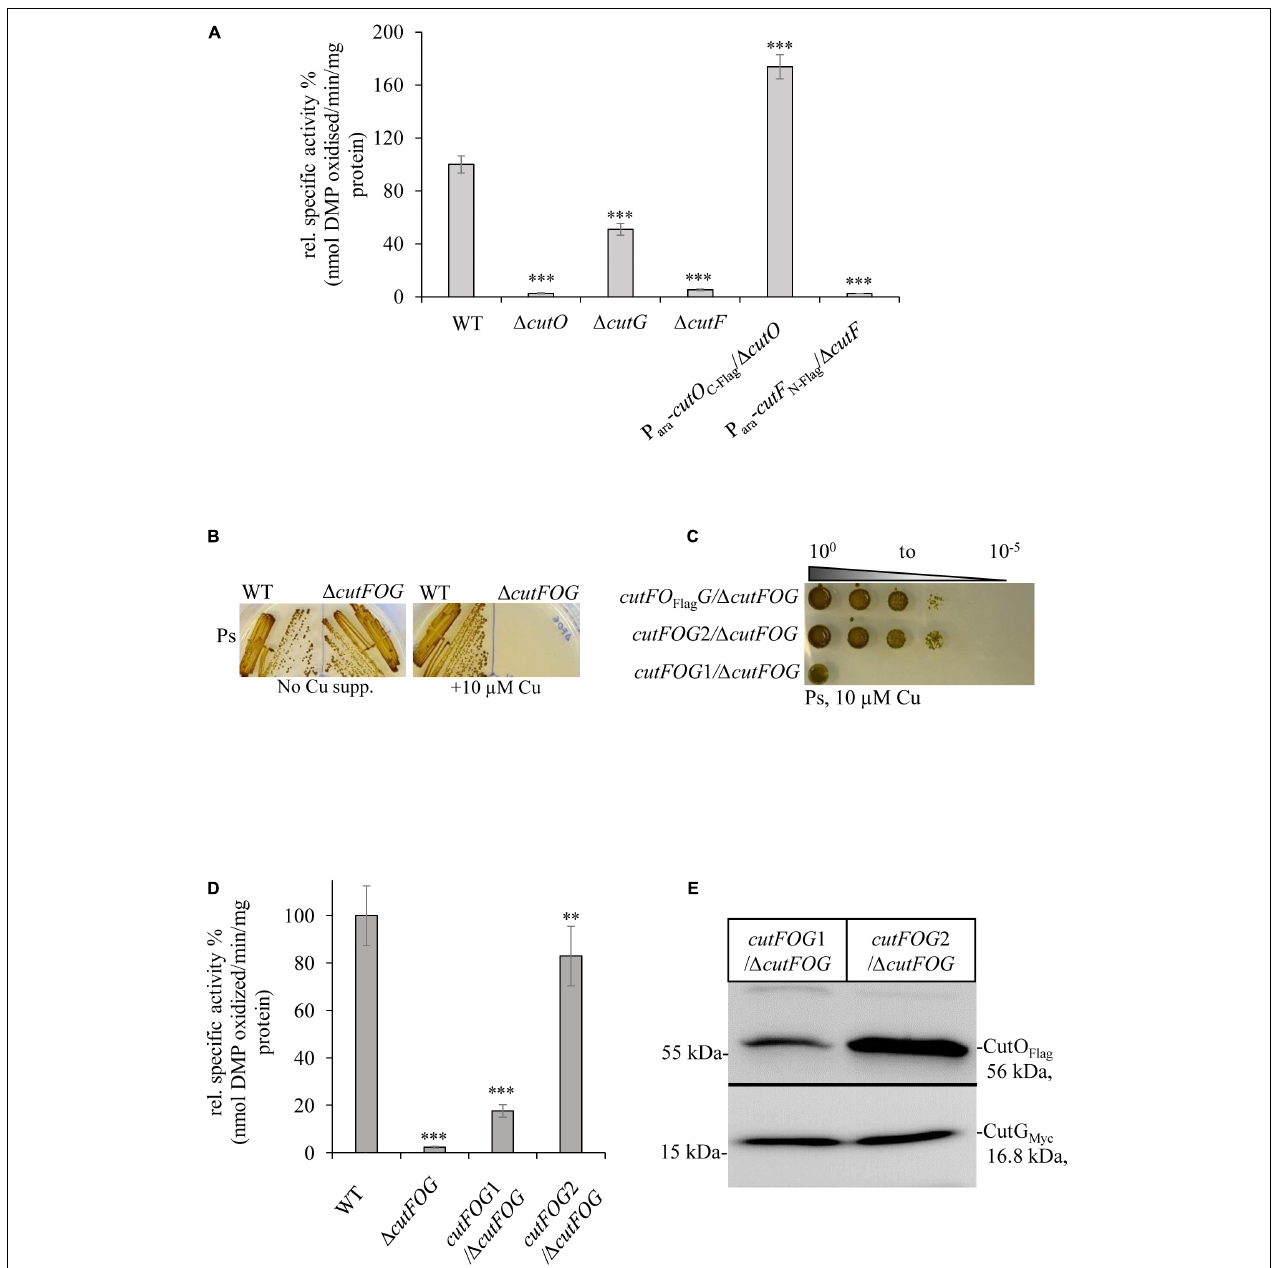
FIGURE 3 | CutF but not CutG is essential for CutO activity. (A) CutO activity of WT and the (cid:49) cutO, (cid:49) cutF, and (cid:49) cutG single mutant strains of R. capsulatus . The CutO activity was determined as described in the legend to Figure 1B . Epitope-tagged versions of cutO and cutF were expressed from an arabinose-inducible promoter from plasmid pRK415. The activity of WT was set to 100% and the relative activities of the indicated strains were calculated. Three independent experiments were performed with three technical replicates and the error bars reflect the standard deviation ( n = 9). Statistical analyses were performed as described in Figure 1 . ( ∗ ) refers to p - values ≤ 0.05; ( ∗∗ ) to p -values ≤ 0.01, and ( ∗∗∗ ) to p -values ≤ 0.001. (B) Cu sensitivity of the WT and the (cid:49) cutFOG triple knock-out strain, grown under PS conditions and in the presence or absence of 10 µ M CuSO 4 . (C) Spot assay for Cu sensitivity of the (cid:49) cutFOG strain expressing differently tagged plasmid-borne copies of the cutFOG- operon. In cutFO Flag G , CutO was C-terminally Flag-tagged. In cutFOG1 ( cutF C − Strep O Flag G MycHis ) and cutFOG2 ( cutF N − strep O Flag G MycHis ), all three genes were tagged, but contained the Strep-tag either at the C-terminus ( cutFOG1 ) or at the N-terminus ( cutFOG2 ) of cutF . (D) CutO activities of the strains shown in panel (C) . Periplasmic fractions were isolated from the indicated strains, grown in MPYE medium supplemented with 10 µ M CuSO 4 . 50 µ g protein of the periplasmic fractions were used in the assay. Three independent experiments were performed with three technical repetitions and the error bars reflect the standard deviation ( n = 9). The activity of WT was set to 100% and the relative activities of the other strains were calculated. Statistical analyses were as in Figure 1 . ( ∗ ) refers to p -values ≤ 0.05; ( ∗∗ ) to p -values ≤ 0.01, and ( ∗∗∗ ) to p -values ≤ 0.001. (E) Immunoblot analyses of the (cid:49) cutFOG strain harboring either the cutFOG1 or cutFOG2 constructs. 50 µ g of soluble protein and α -Flag antibodies were used for the detection of CutO (upper panel) and 75 µ g protein and α -Myc antibodies were used for detection of CutG (lower panel). Although Strep-tagged, CutF could not be detected in immunoblots in either construct, although the cutFOG2 construct fully complemented the (cid:49) cutFOG strain.